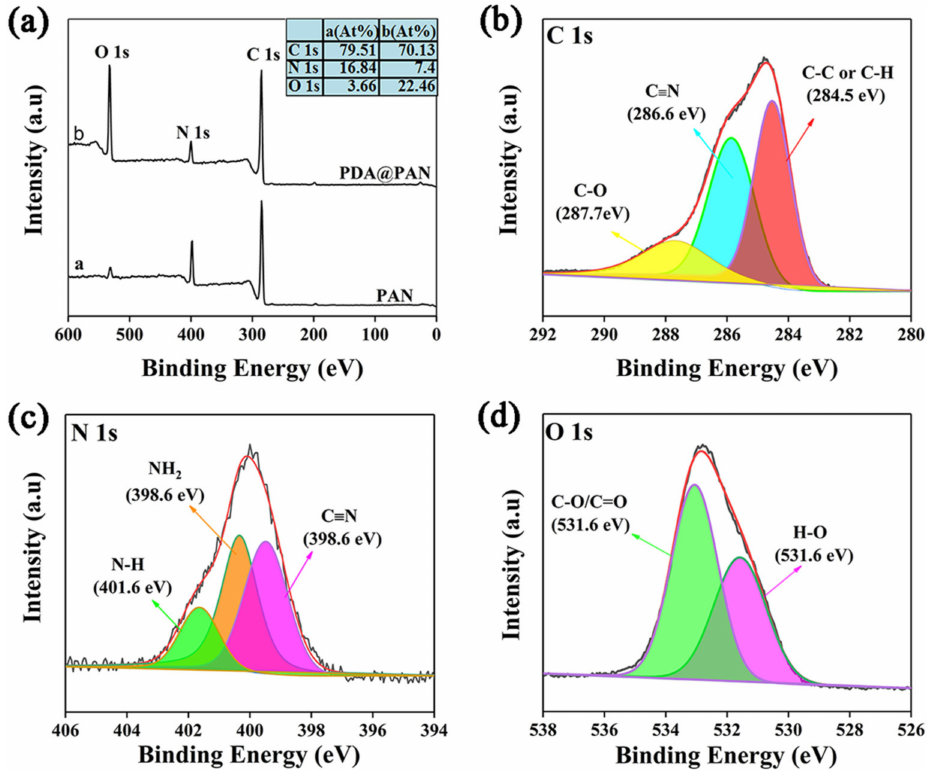
Figure 5. XPS full spectra of PAN and PDA@PAN nanofibrous membrane ( a ) and deconvoluted XPS spectra of C 1s ( b ), N 1s ( c ) and O 1s ( d ) elements; the inset table in ( a ) shows relative atomic